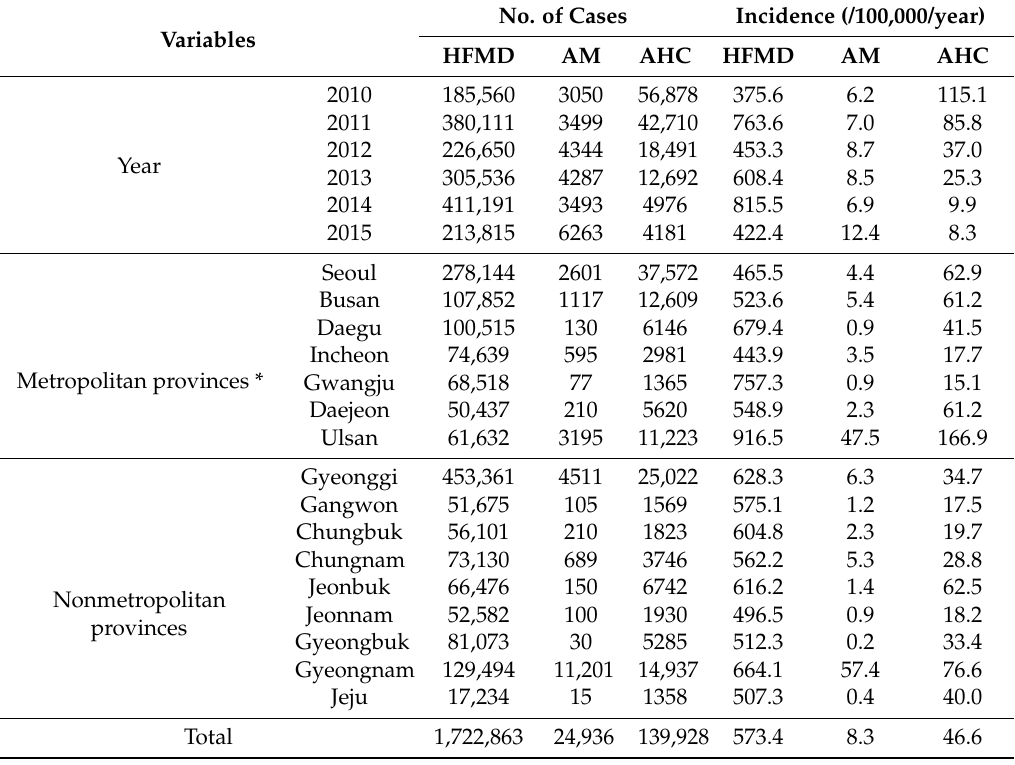
Table 1. General description of enteroviral disease cases from 2010 to 2015 in Korea.